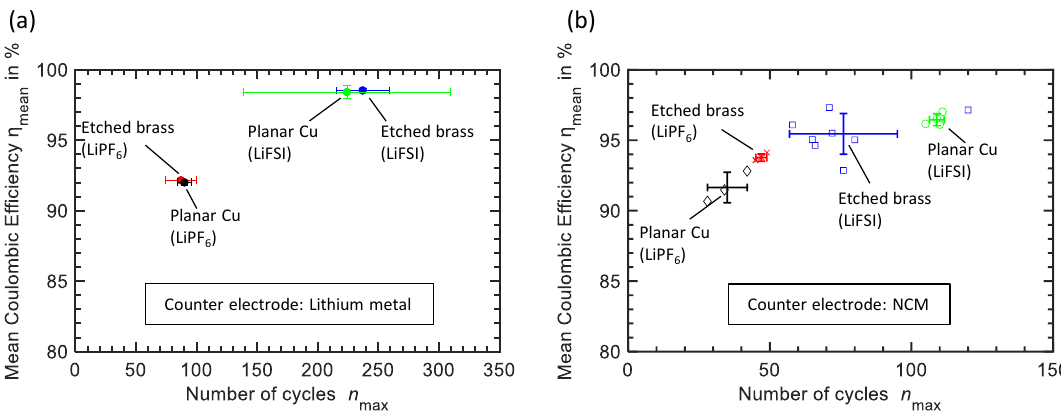
Figure 7. Cycle performance of different current collectors with an electrolyte of 1M LiPF 6 in EC:DEC:FEC: 4.5:4.5:1 (wt.) from Figure 4 and with an electrolyte of 2 M LiFSI in DME represented as the mean Coulombic efficiency and the mean maximum number of cycles with standard deviation. ( a ) Experiments against Li counter electrode. ( b ) Experiments against NCM counter electrode. Additionally results of single cells are